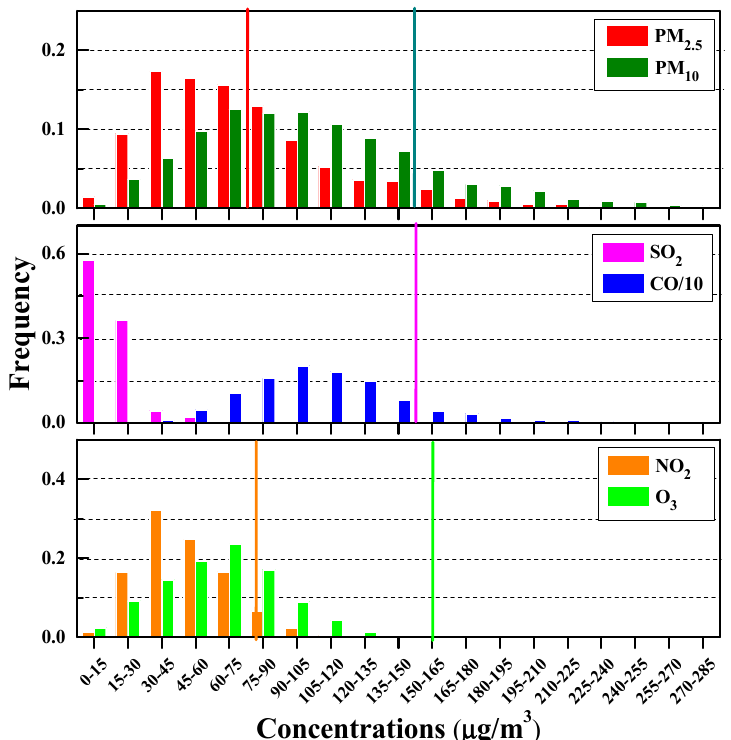
Figure 3. Frequency distribution of six criteria pollutants during the wintertime in the YREB. The perpendicular lines represent the Grade II standard for the ambient criteria air pollutants, except CO. Int. J. Environ. Res. Public Health 2020 , 17 , x 9 of 18